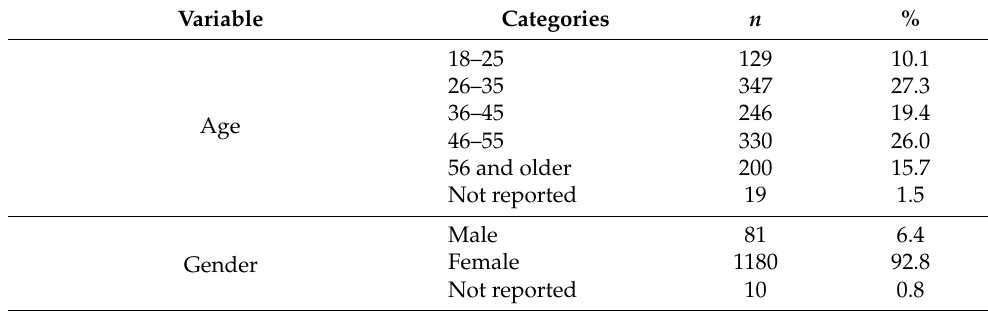
Table 1. Participant Characteristics ( n =